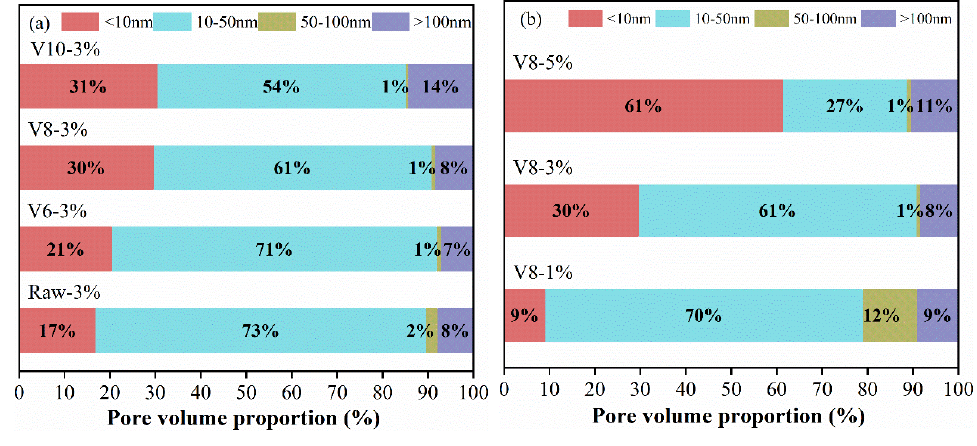
Figure 13. The pore-volume distribution of hardened specimens at 28 d: effect of BFS fineness ( a ) and effect of NC dosage ( b ).